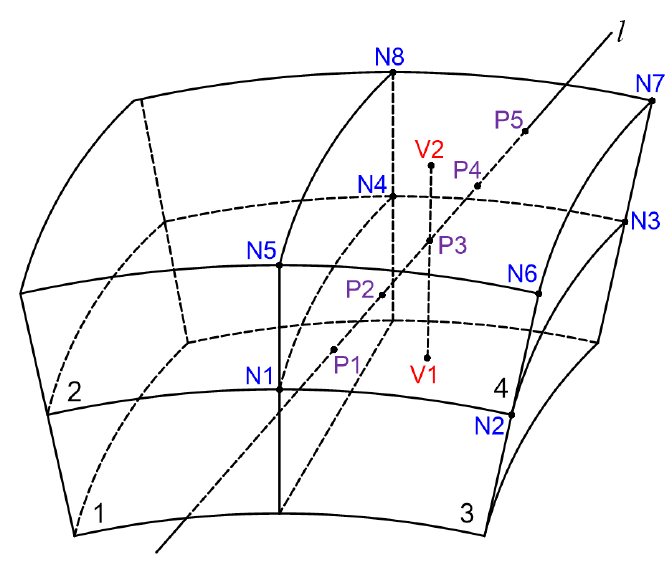
Figure 1. Schematic representation of voxel discretization for the tomographic model.